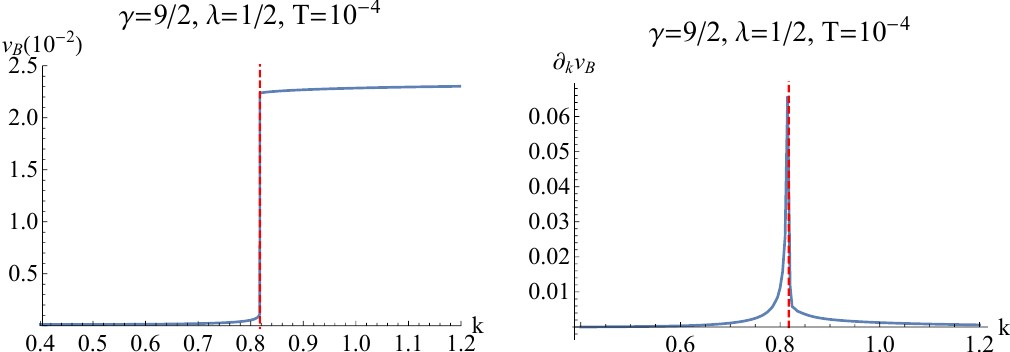
Figure 6 . The butterfly velocity v B and its derivative with respect to k as the function of k for γ = 9 / 2 at T = 10 − 4 . The red dashed lines are the positions of QCPs. Here we choose λ = 1 / 2